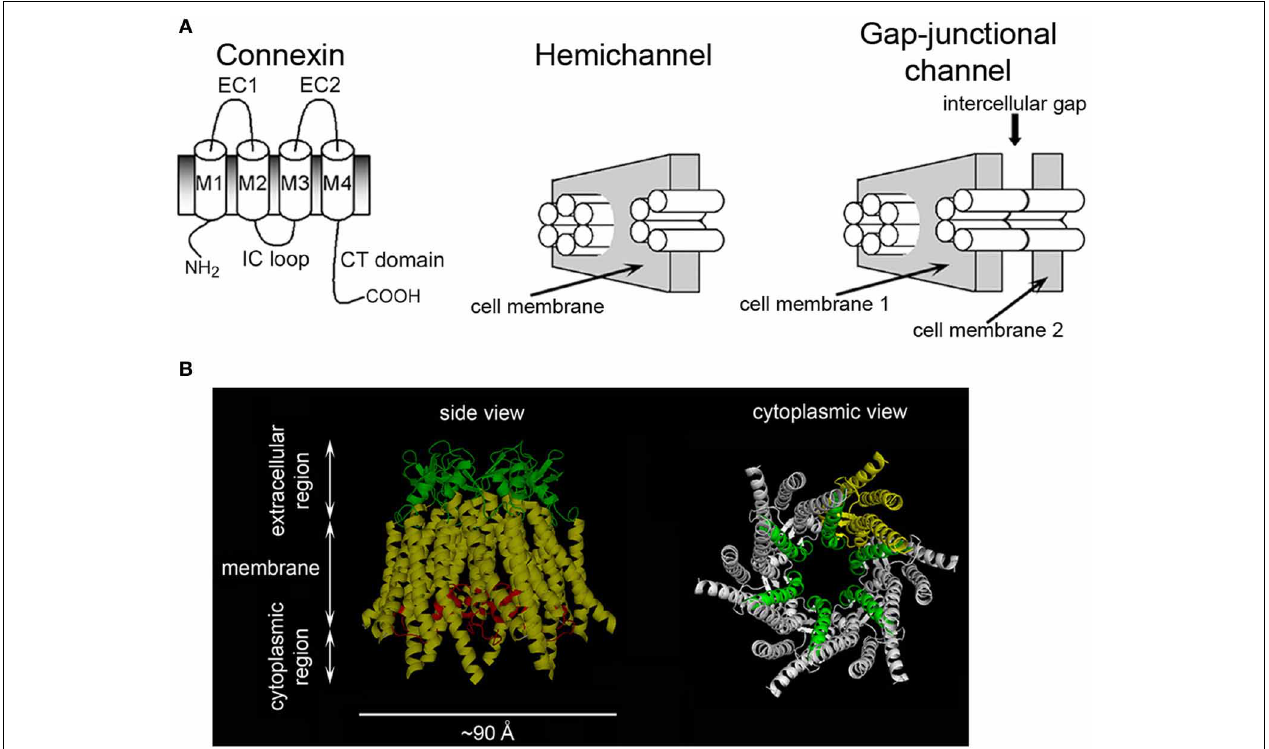
FIGURE 1 | Connexins, hemichannels, and gap-junctional channels. (A) Representation of a connexin, a HC and a GJC. M1-M4: trans-membrane helices; EC1 and EC2: extracellular loops; IC loop: intracellular loop. Modified from Bao et al. (2005). (B) Cx26 HC structure. Left: transmembrane helices (yellow), EC loops (green), and N-terminal